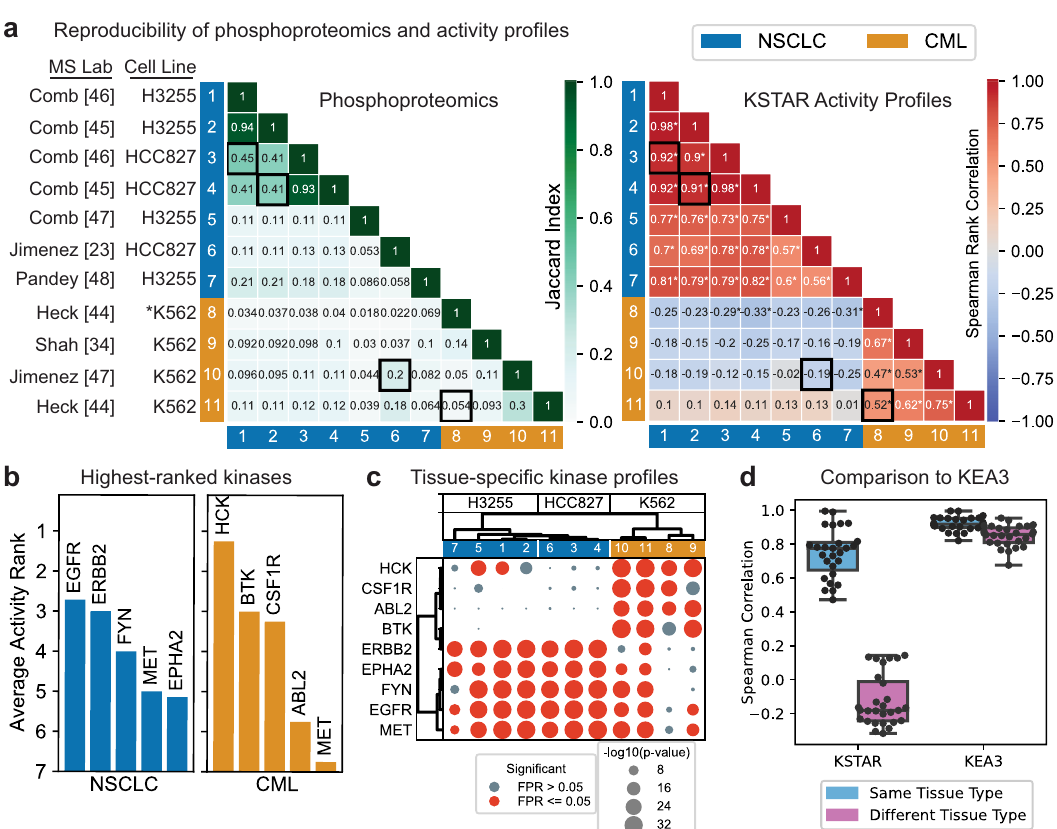
Fig.5|Tissue-speci fi cpro fi lesofkinaseactivitiesacrossindependentstudiesof non-small cell lung carcinoma (NSCLC) and chronic myeloid leukemia (CML) cell lines. a Comparison of the phosphoproteomic results obtained by each study (left) and the kinase activity pro fi le predicted by KSTAR (right). We used similarity metrics to match the different data types -- Jaccard similarity for phosphopro- teomics and Spearman ’ s rank correlation for kinase activity pro fi les. The ordering of the experiments in each heatmap is based on hierarchical clustering of the full kinase activity pro fi le (Supplementary Note 5). b Kinases with the highest average activity ranking in NSCLC and CML cell lines. A rank of 1 indicates the most active kinase and a rank of 50 indicates the least active. For each study, kinases were sorted by their Mann-Whitney p -values to obtain the experiment-speci fi c ranking, and then the average rank across experiments was calculated for each kinase. c Kinase activity pro fi les for top-ranked kinases. Both the kinases and experiments